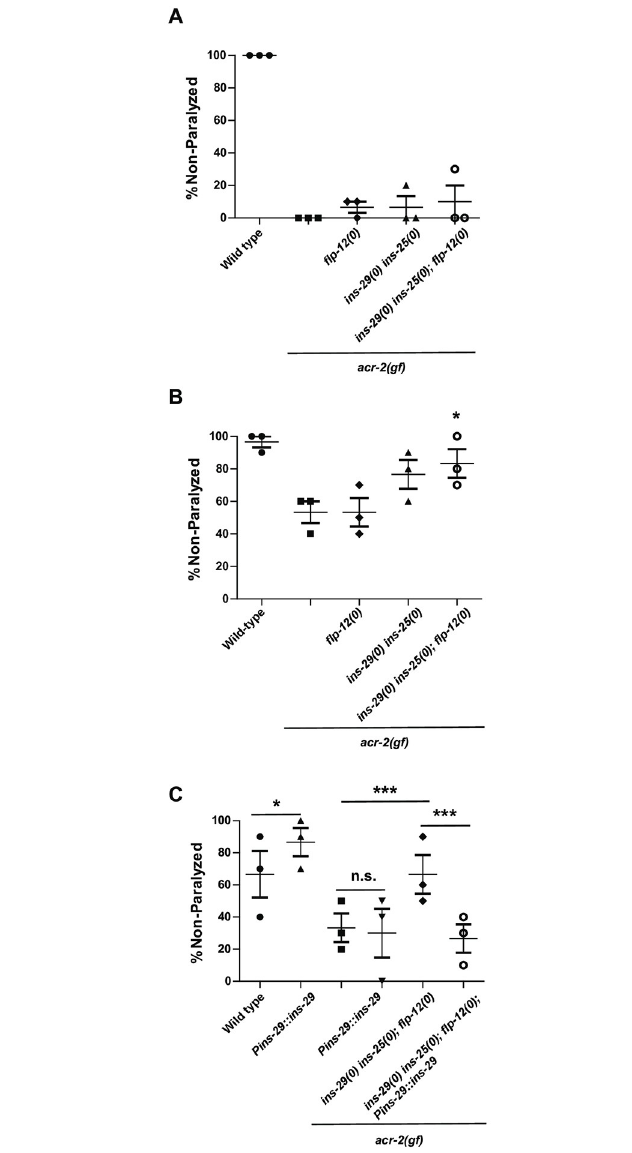
Fig 6. ILPs regulate post-synaptic muscle excitability. A. Aldicarb sensitivity shown as percentage of animals not paralyzed after 1hour on the drug. No significant difference was observed (Two-way ANOVA followed by Dunnett’s test, compared to acr-2(gf) alone.). Each data point represents one trial and 10 animals per genotype were scored per trial. Data is also shown in S3 Table. B. Levamisole sensitivity of neuropeptide mutants in the acr-2(gf) background at 15min. Deletion of insulin-like peptides with flp-12(0) significantly reduces levamisole sensitivity compared to acr-2 (gf) at this timepoint. Each data point represents one trial and 10 animals per genotype were scored per trial ( � P < 0.05, Two-way ANOVA followed by Dunnett’s test compared to acr-2(gf) single mutant.). Data is also shown in S5 Table. C. Effect of ins-29 over-expression on levamisole sensitivity. Shown are a subset of mutant strains analyzed in Fig 6B also carrying the ins-29 over-expression transgene ( juEx7966 ). Over-expression of ins-29 can restore acr-2(gf) levels of levamisole sensitivity to that of ins-29(0) ins-25(0); acr-2(gf) strains, but also inhibits levamisole sensitivity in wild-type circuits. Each data point represents one trial and 10 animals per genotype were scored per trial ( ��� P < 0.001, � P < 0.05. Two-way ANOVA followed by Bonferroni test.). Data is also shown in S7 Table.